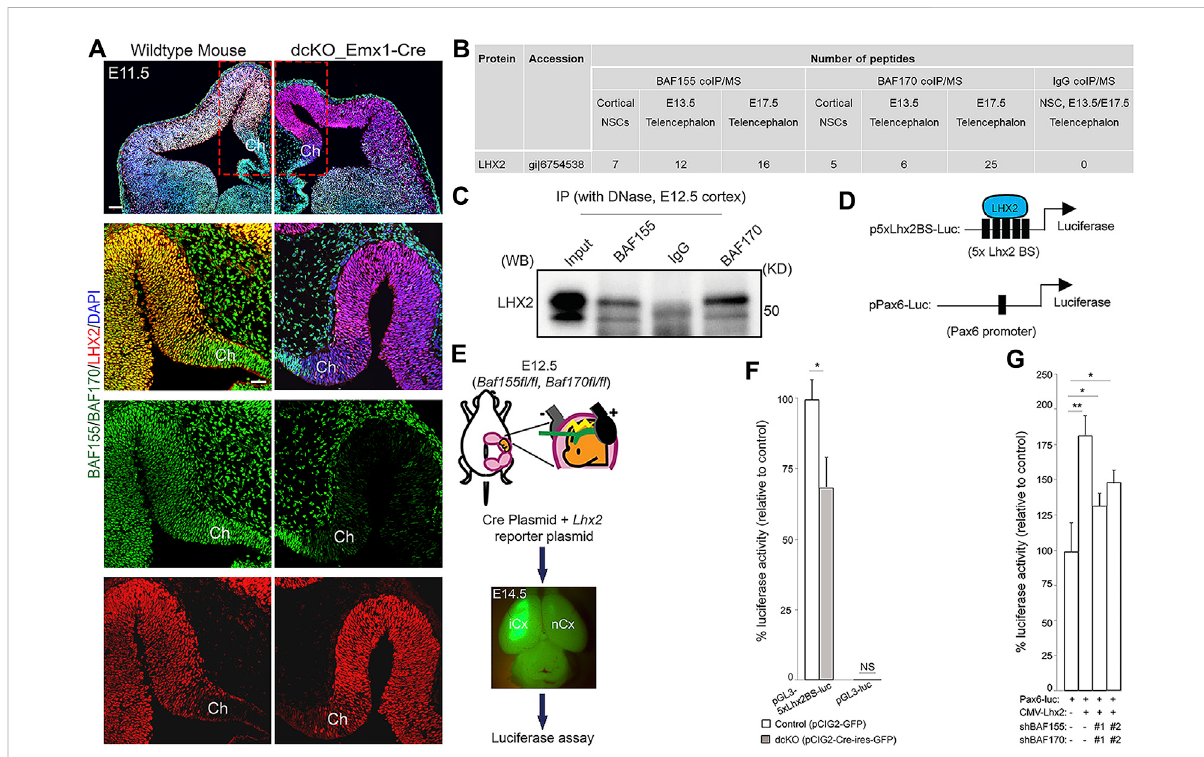
FIGURE 5 BAF complex interacts with LHX2 in the neocortical neuroepithelium. (A) Immunomicrographs showing the E11.5 control and BAF complex mutantmousetelencephalonstained forBAF155,BAF170, andLHX2.Colocalization ofBAF complex isindicated byyellow signal.A close-up view of the medial pallium and cortical hem is shown. (B) Image of table indicating the number of LHX2 peptides puri fi ed from immunoprecipitates of BAF155 andBAF170 obtained fromNS5 cellproteinextracts, andfrom theE13.5orE17.5 dorsaltelencephalon proteinextract. IgGcoIP/MS was used as control. (C) Interaction of BAF155 and BAF170 with LHX2 was con fi rmed by coIP/western blot analyses of E12.5 dorsal telencephalic tissue. (D) Illustrations showing the plasmids ( p-5xLhx2BS-luciferase and pPax6-Luc ) used for the luciferase assay. The multiple (5x) Lhx2 binding sites (BS) for augmenting LHX2-dependent promoter activity is depicted in p-5xLhx2BS-luciferase , whereas pPax6-Luc has one Lhx2 binding sites. (E) Image showing scheme for in vivo luciferase assay. (F,G) Bar charts representing the statistical comparisons of (F) In vivo LHX2-mediated luciferase activity in the control or dcKO_Emx1-Cre cortex, and (G) In vitro PAX6-mediated luciferase activity in culture Neuro2A cells in the presence or absence of BAF155, BAF170 or LHX2 permutationally as indicated. In both cases, two variants of shRNAs (#1 and #2) were used to knockdown BAF155